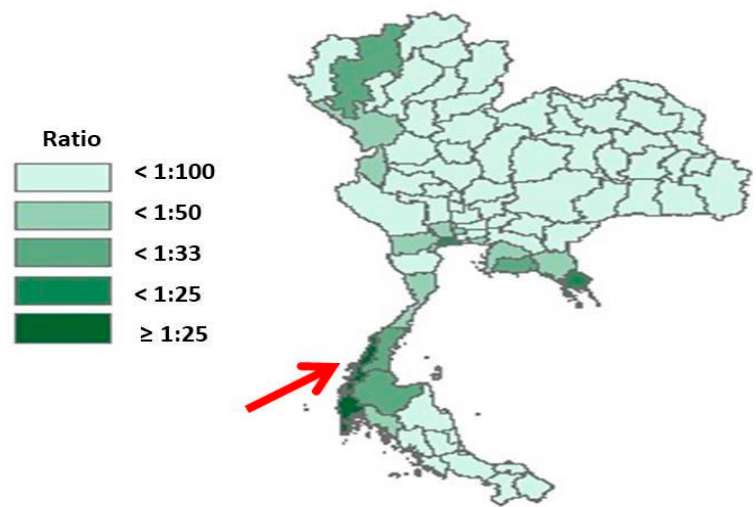
Figure 3. Ratio of registered migrants to Thai citizens in all provinces in Thailand, 2013. Source: adapted from Health Insurance Group, the MOPH [11].